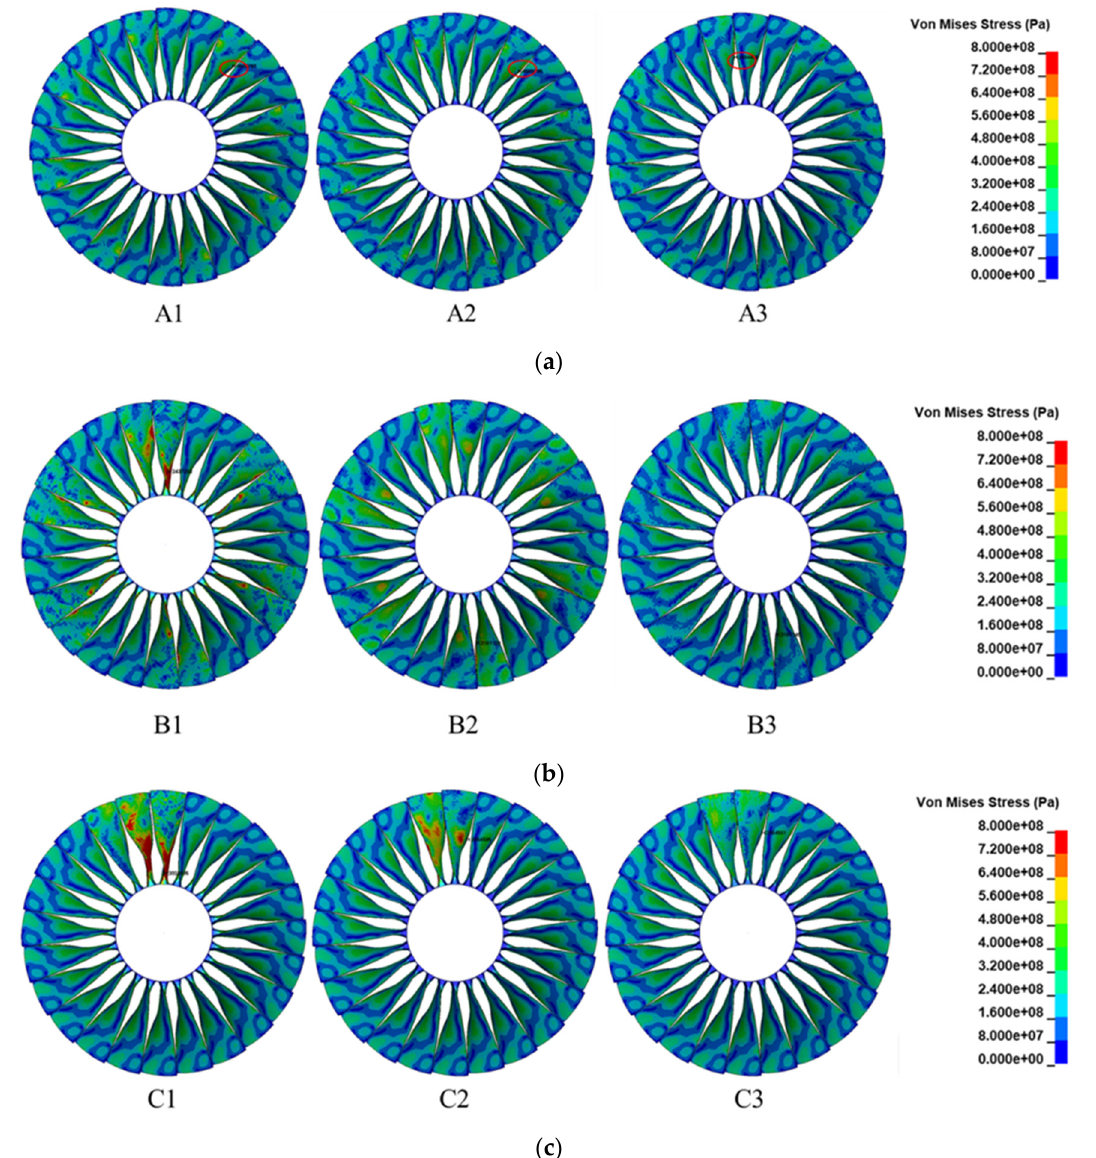
Figure 7. Distribution of Von Mises stress after impact by: ( a ) small flocking birds; ( b ) medium flocking birds; ( c ) large single bird.